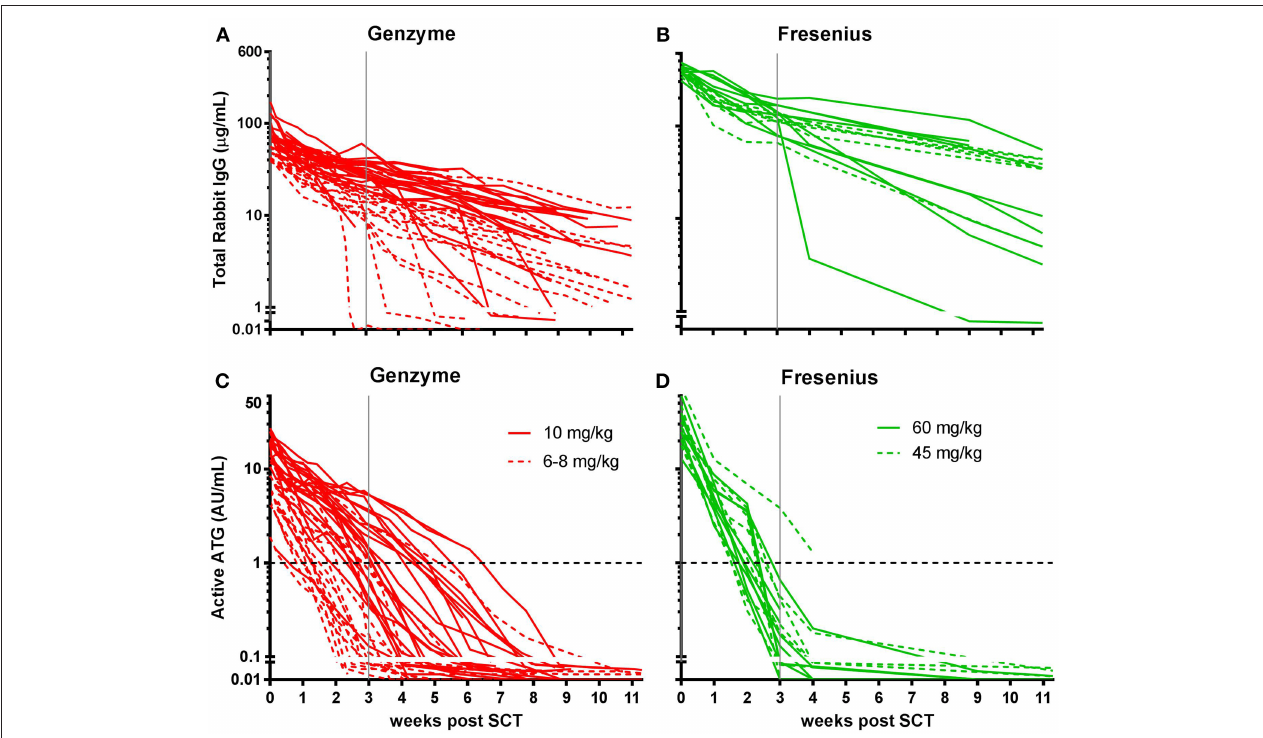
FIGURE 1 | Serum/plasma concentration of total Rabbit IgG (total ATG) and active ATG in ATG-GENZ (Genzyme, red) or ATG-FRES (Fresenius, green) treated patients. Total Rabbit IgG ( µ g/mL) of ATG-FRES treated patients (B) was higher in comparison with ATG-GENZ treated patients (A) , because of the higher dose of ATG-FRES given, but clearance was comparable for both brands. Active ATG levels (AU/mL) of ATG-FRES treated patients (D) , receiving 60 mg/kg (solid lines; n = 9) or 45 mg/kg (dashed lines; n = 7), decreased fast and was only in 1 out of 16 patients (6%) above 1 AU/mL at 3 weeks post-HSCT. ATG-GENZ treated patients (C) receiving 10 mg/kg (solid lines; n = 24) or 6–8 mg/kg (dashed lines; n = 18) showed more variance in clearance. At 3 weeks post-HSCT 15 out of 24 patients (63%) receiving 10 mg/kg had active ATG levels above 1 AU/mL vs. only 2 out of 18 patients (11%) receiving 6–8 mg/kg. The horizontal dashed line at 1 AU/mL marks the highest serum/plasma concentration at which T-cells can reappear in the blood. The vertical solid gray line is the expected time of neutrophil engraftment. Of note, in the 6 patients receiving ATG-GENZ and showing a steep decline of rabbit ATG IgG antibodies against rabbit IgG were detected.